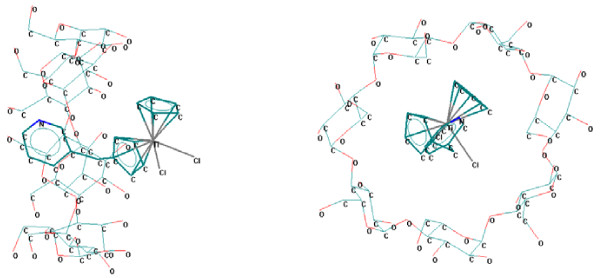
Titanocene (code 23TC) / β-cyclodextrin supramolecular system (theoretically modeled by MM+).